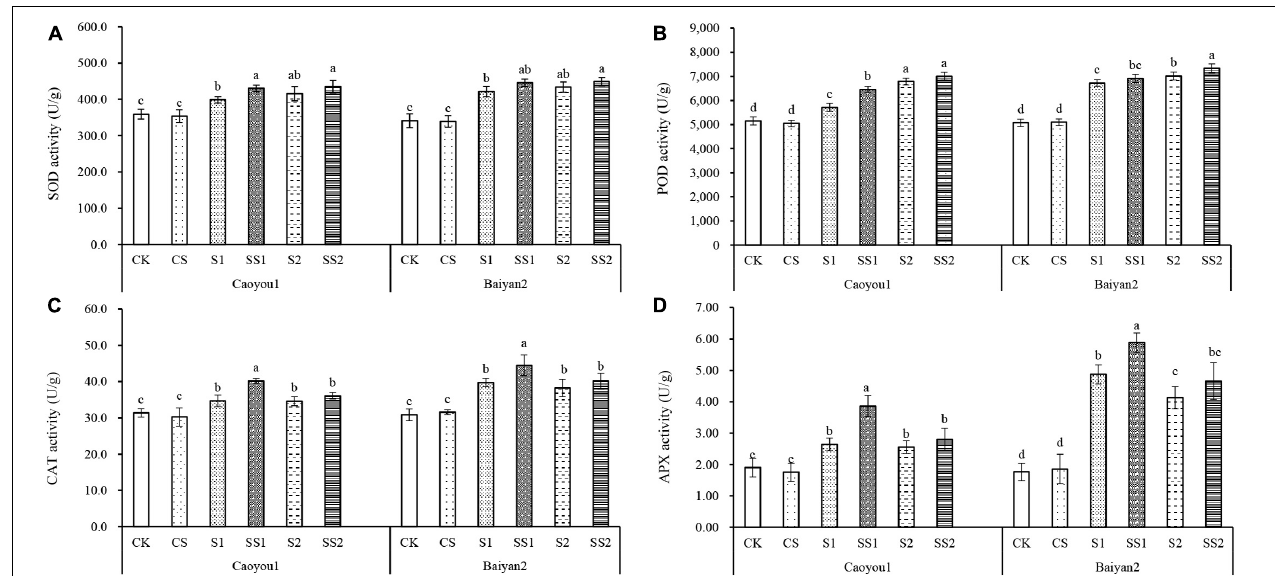
FIGURE 3 | Effects of Spd application on SOD (A) , POD (B) , CAT (C) , and APX (D) under salt stress in the oat seedlings. CK, Nutrient solution + distilled water; CS, Nutrient solution + 0.75 mM Spd; S1, 70 mM salt + distilled water; SS1, 70 mM salt + 0.75 mmol/L Spd; S2, 100 mM salt + distilled water; SS2, 100 mM salt + 0.75 mmol/L Spd; Different lowercase letters indicate significant differences between treatments at 0.05 level.